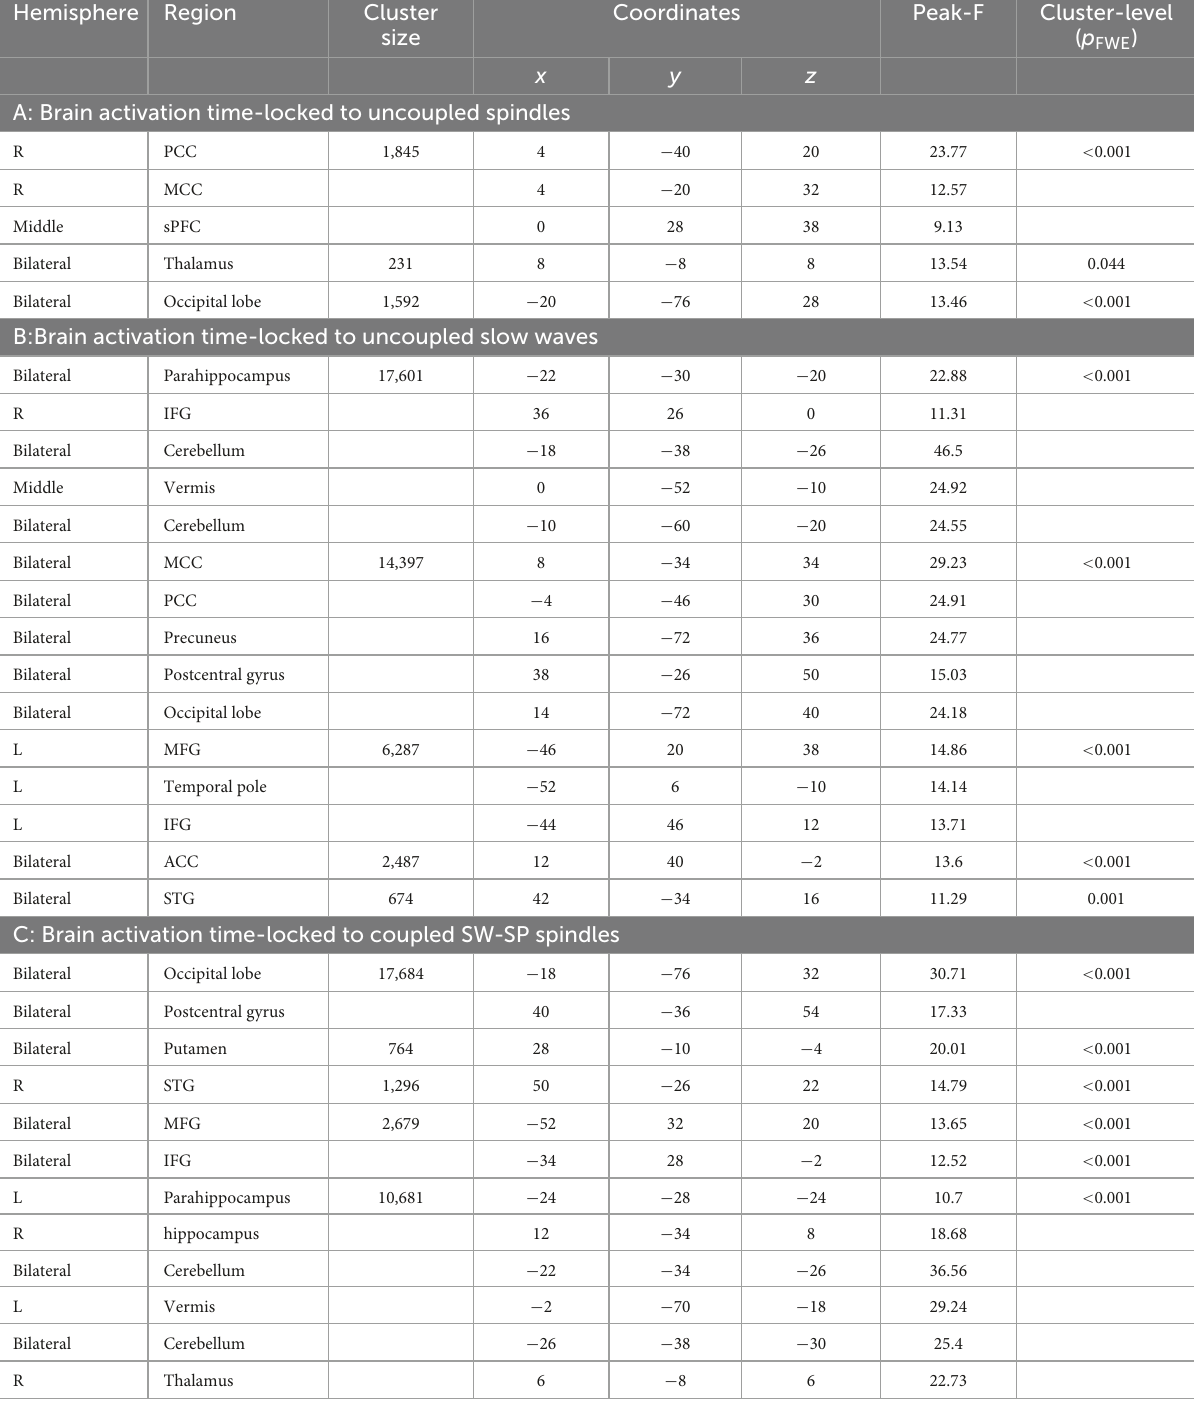
TABLE 2 Cerebral activations time-locked to: (A) uncoupled spindles, (B) uncoupled slow waves, and (C) coupled SW-SP. Hemisphere Region Cluster Coordinates Peak-F Cluster-level size